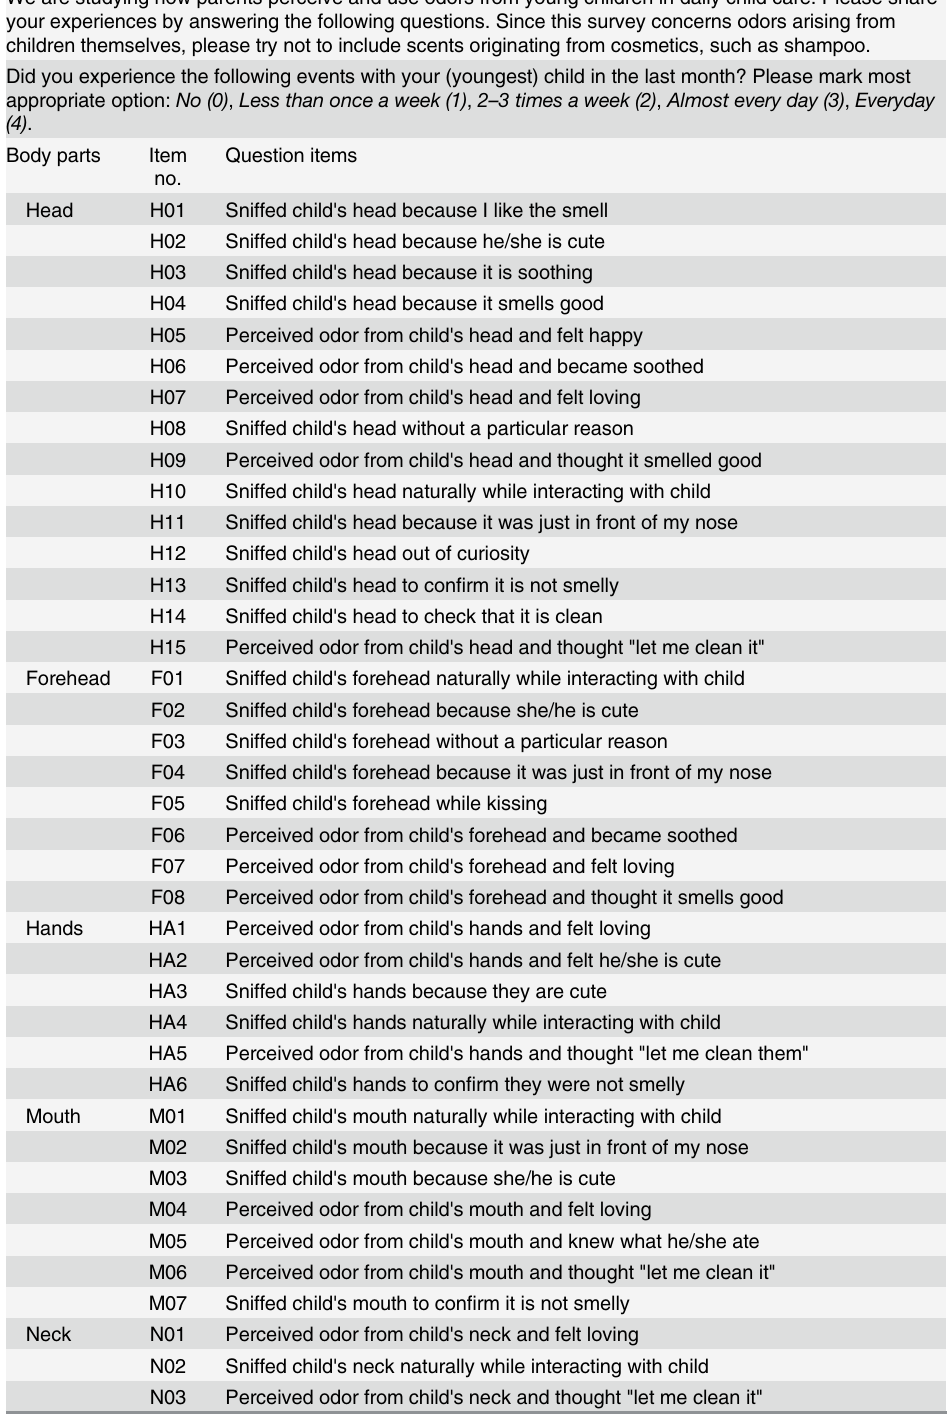
Table 1. Child Odor in Parenting scale